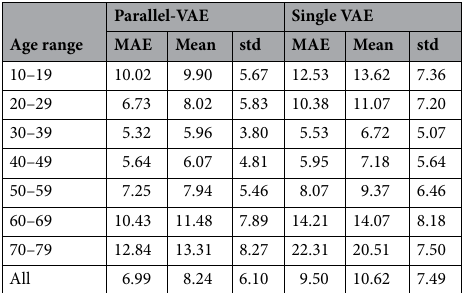
Table 3. Prediction accuracy of each training model, MAE is the median absolute error.